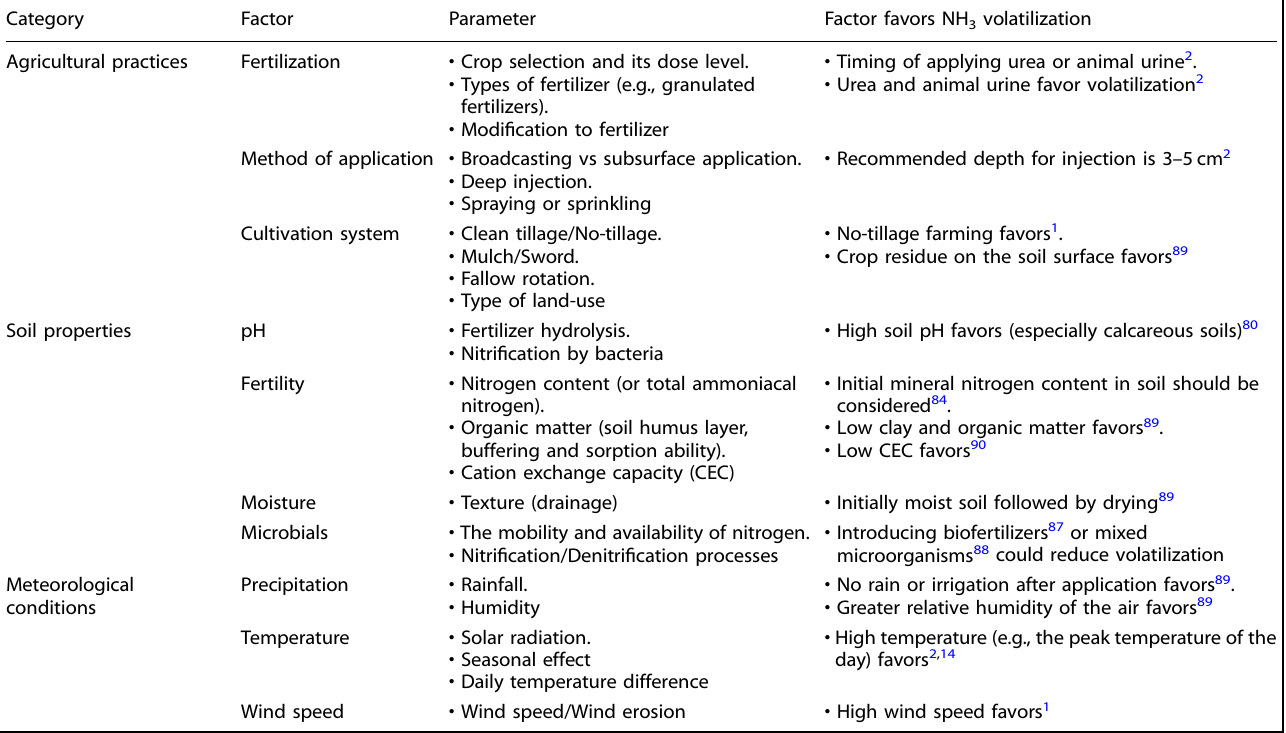
Table 3. Effect of farming systems and management on NH 3 volatilization losses from farm lands.